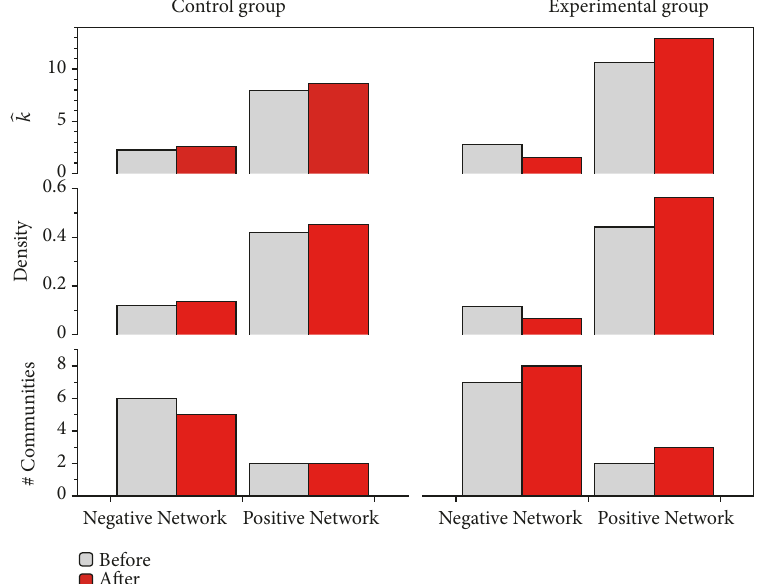
̂𝑘 (top), link density (mid), and number of communities (bottom), for